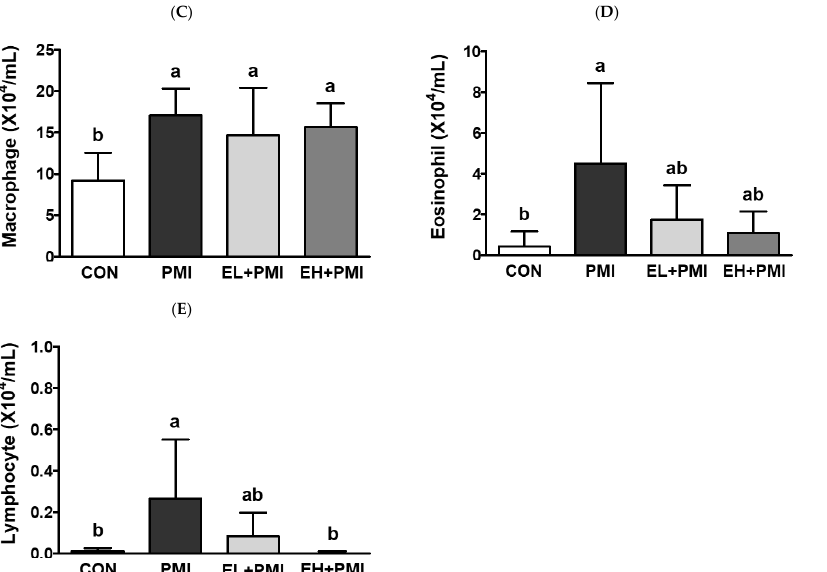
Figure 3. Inflammatory cell profiles in the bronchoalveolar lavage fluid (BALF) after ellagic acid (EA) pretreatment and particulate matter (PM) instillation. C57BL/6 mice were orally pretreated with ellagic acid (EL; 20 mg/kg or EH; 100 mg/kg) for 7 days, and then PM (5 mg/kg) was intratra- cheally administrated for 7 days with or without ellagic acid pretreatment. All the cells in the BALF were stained with Diff-Quik solution and counted: ( A ) total cells, ( B ) neutrophils, ( C ) macrophages, ( D ) eosinophils, and ( E ) lymphocytes. Values represent the mean ± standard deviation (SD) for each group ( n = 8 ). Based on the D’Agostino and Pearson omnibus test, one- way ANOVA with Tukey’s post hoc test (for ( A – C , E )) or Kruskal –Wallis test with Dunn’s post hoc test (for ( D )) was applied. Lowercase letters indicate significant differences. p < 0.05.